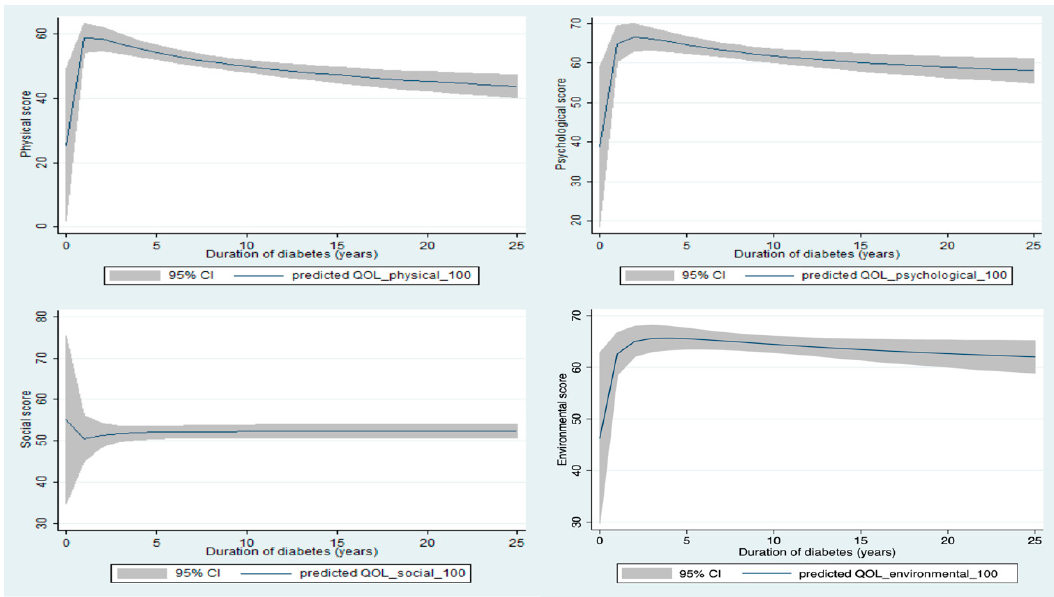
Figure 1. Correlations between diabetes duration and WHOQOL-BREF domain scores. QOL: quality of life.